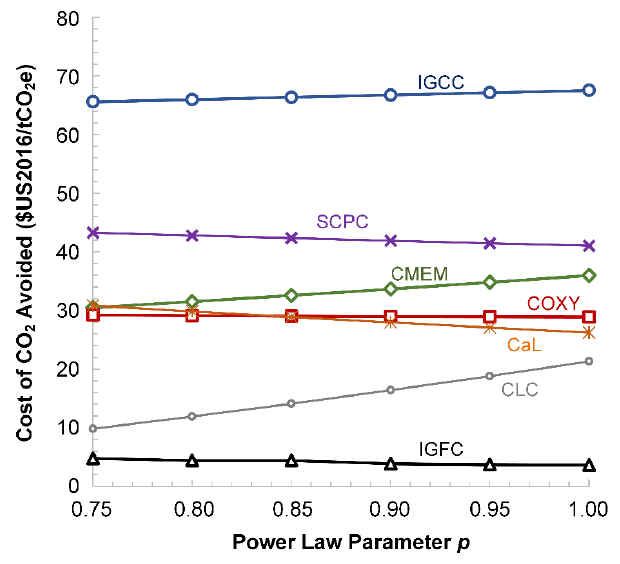
Figure 16. The average values of the CCA vs. SCPC without CO 2 capture for as-reported fuel prices as a function of the assumed power law parameter p